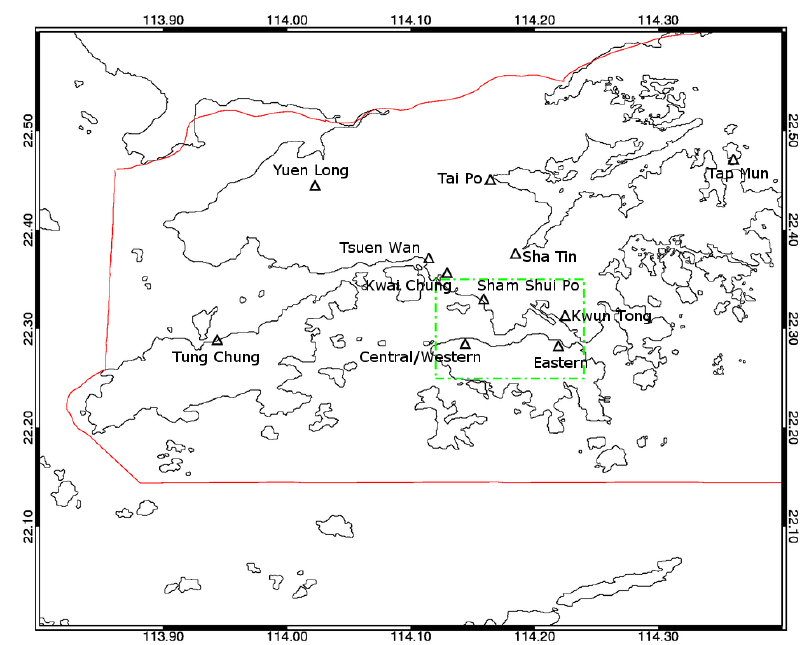
Figure 1. The in situ NO 2 stations from the HK-AQN used in this work. The red line indicates the international boundary of the Hong Kong SAR, which this work focuses on. The green rectangle represents the Kowloon district and Hong Kong Island, from which the time series in Sect. 3.8 was